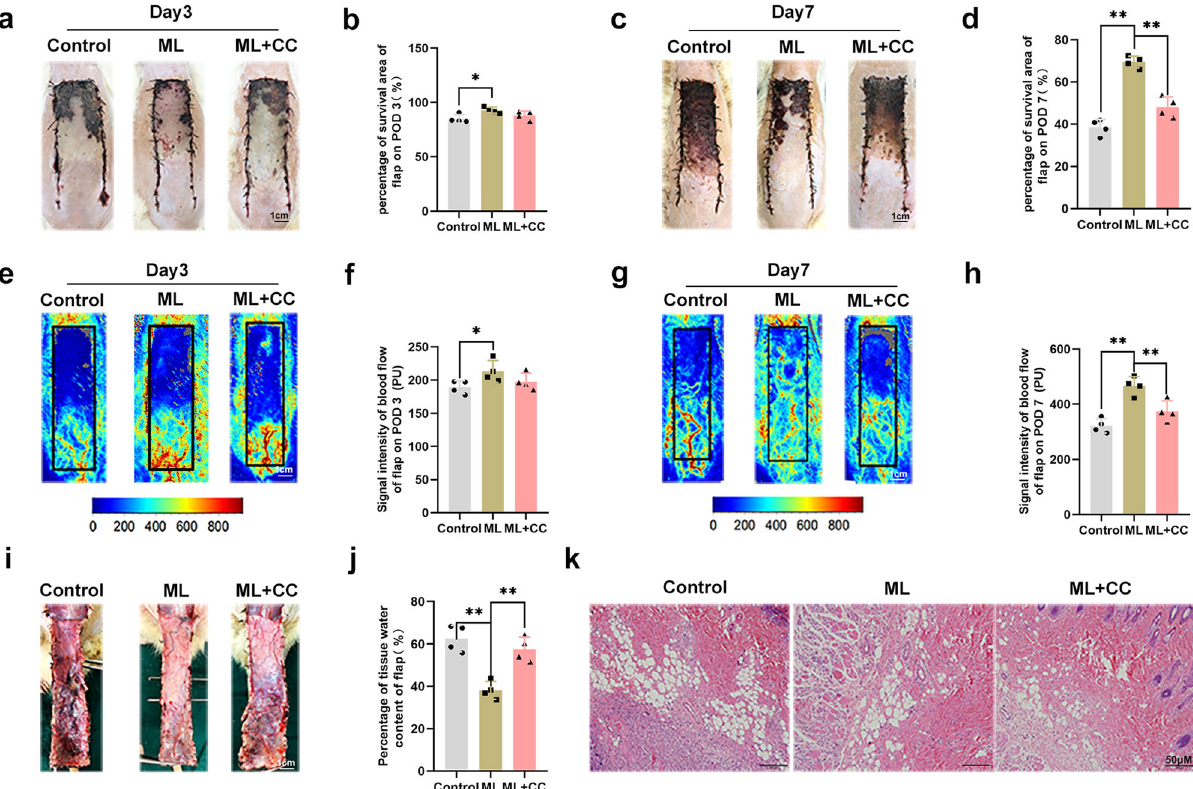
Fig. 7 ML promoted random-pattern skin fl ap survival and was reversed by AMPK inhibitor. a , c Digital photograph of the fl ap on POD 3 and POD 7 (bar: 1 cm). b , d Percentages of survival area on POD 3 and POD 7 were quanti fi ed and demonstrated by the histogram. e , g Laser Doppler was carried out to visualize the blood supply under the fl ap on POD 3 and POD 7 (bar: 1 cm). f , h Quantify the signal intensity of blood fl ow. The stronger the signal intensity, the greater the blood fl ow. i Image of tissue edema and Subcutaneous vascular network in control, ML, and ML + CC groups on POD7 (bar: 1 cm) ( n = 4). j Percentage of tissue water in each group. k Representative histological images of skin fl aps exhibiting blood vessels and in fl ammation (bar, 50 μ m). Data are presented as mean ± S.D. n = 4 per group, ** P < 0.01, * P <